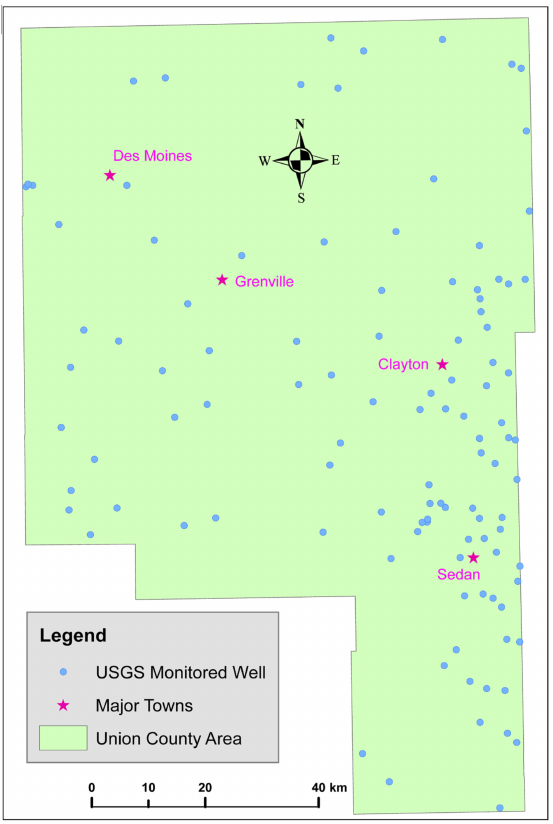
Figure A3. The USGS monitored wells that recorded groundwater level data during the study period (2007–2019). Note: A total of 111 well locations are illustrated on the map. There is only one weather station in the county (Clayton Municipal Airpark (KCAO); Lat: 36.45 ◦ N; Lon: 103.15 ◦ W), located near Clayton. Data sources: US Geological Survey; US